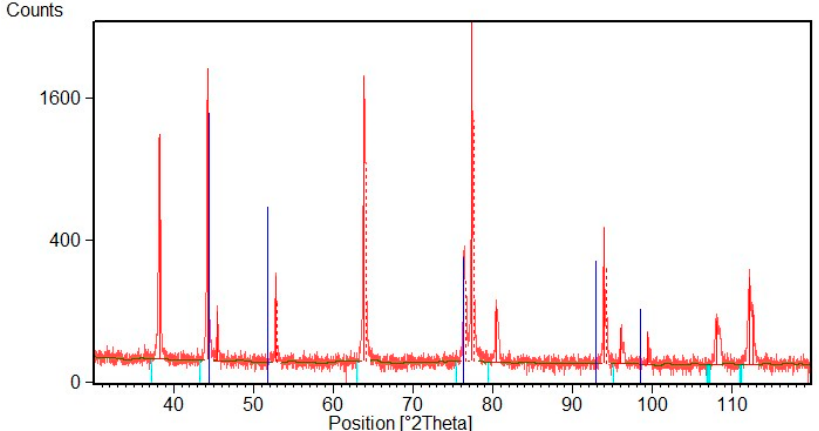
Figure 10. XRD di ff raction pa tt ern of Ni deposit after heat treatment at 170 °C.